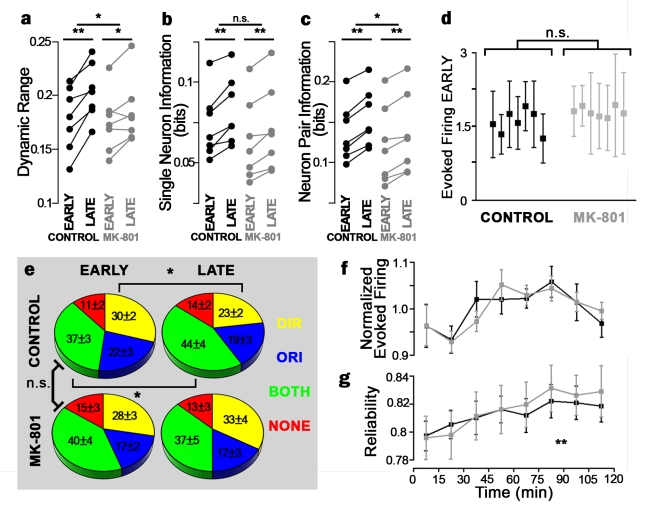
Effects of visual training on single-neuron response properties.(a) Tuning curve dynamic range, the fraction by which a neuron's firing changes in response to different stimuli during early and late epochs. (b,c) Stimulus mutual information conveyed by single neuron (b) and neuron pair (c) firing patterns. Upper asterisks denote difference in the change with treatment. Lower asterisks denote significant change across epochs (paired t-test). (d) Evoked firing rates in control (black) and MK-801 treated (gray) tadpoles during first hour of stimulation. Each point corresponds to a single tadpole; error bars denote standard deviation across neurons within a given tadpole. MK-801 does not acutely affect evoked firing rates (t-test, p = 0.61). (e) Proportion of neurons showing direction (yellow), orientation (blue), both (green), or neither (red) selectivity in control (top) and MK-801–(bottom) treated tadpoles, in the first (left) and second (right) hour of stimulation. Asterisks denote significant change across epochs (paired t-test). (f,g) Mean normalized amplitude (f) and response reliability (g) over the course of visual training (black). Reliability increased with training (ANCOVA, p<0.01). Neither measure was affected by MK-801 (gray) (ANCOVA, p>0.05). Reliability is the proportion of evoked responses with amplitude larger than the median spontaneous firing rate. Error bars denote SEM. *p<0.05.